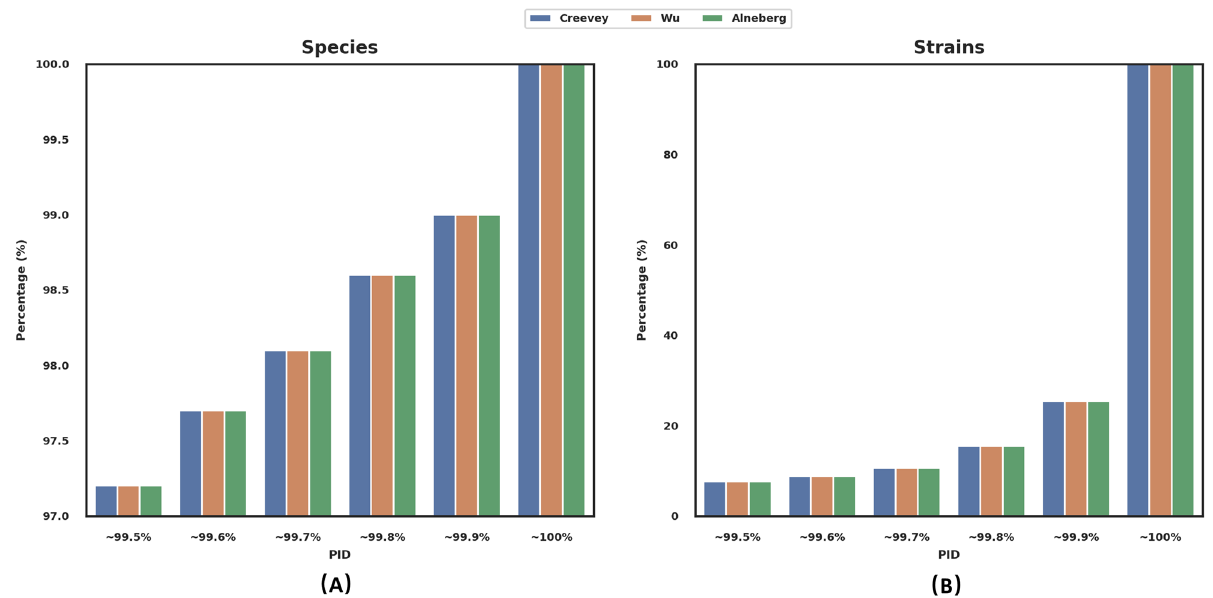
Figure 3. The cumulative distribution of the PID of species pairs and strain pairs. ( A ) Species pairs. ( B ) Strain